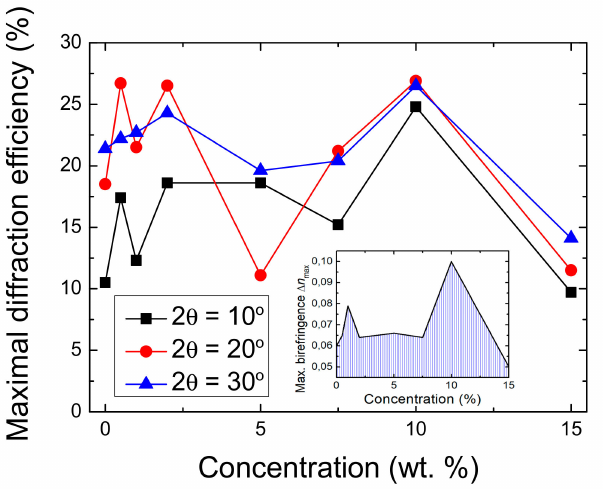
Figure 5. Dependence of the maximal diffraction efficiency in the +1 order (DE +1 max ) on the concen- tration of the goethite nanorods in the thin film samples for all recording angles—2 θ = 10 ◦ , 20 ◦ , and 30 ◦ . The inset shows the dependence of the photoinduced birefringence ( ∆ n max ) on the nanorods concentration (adapted from